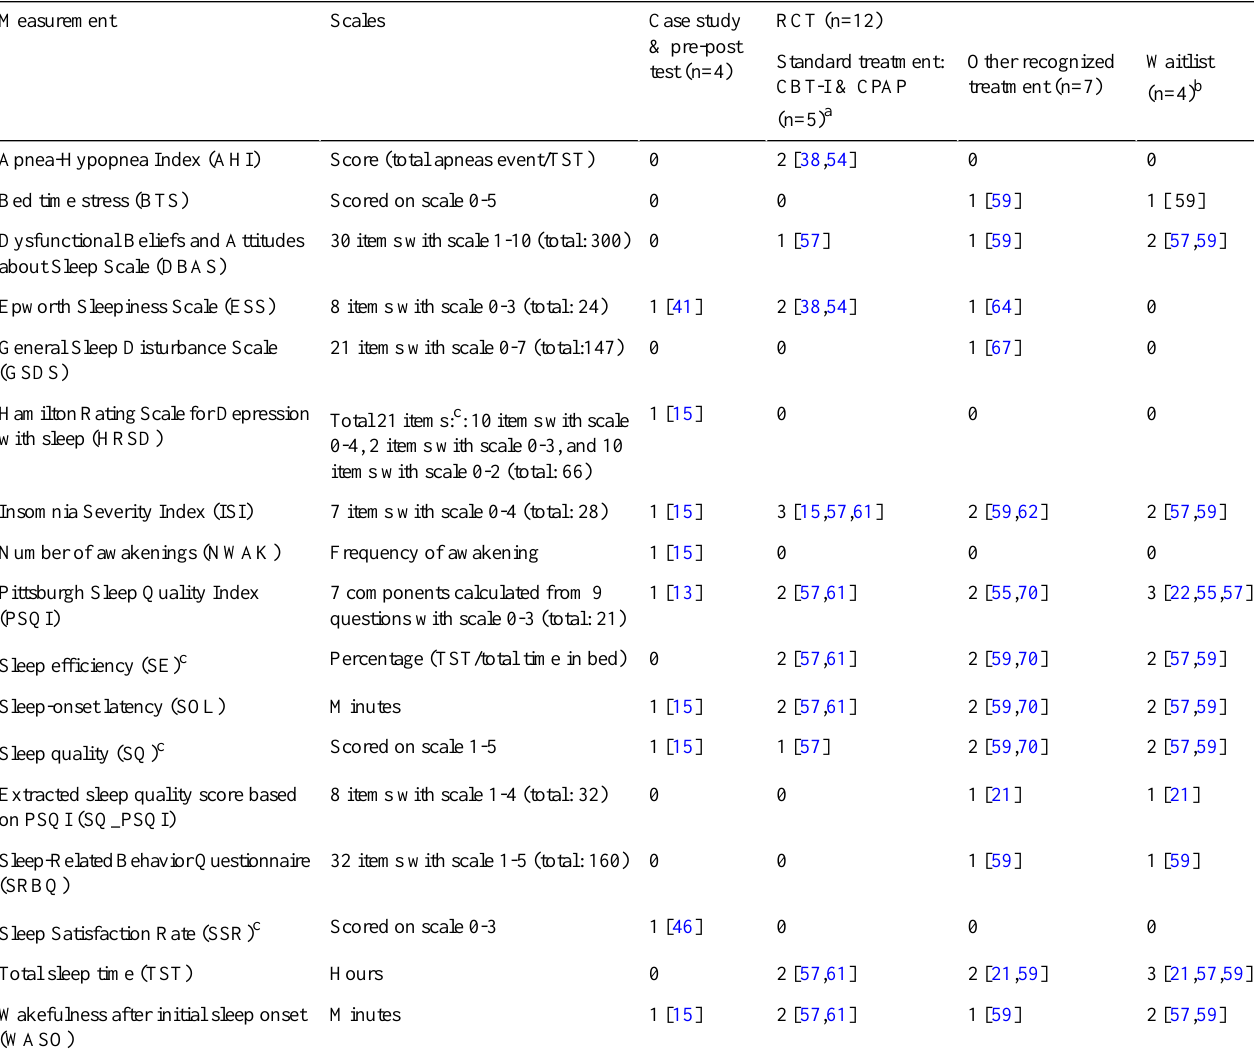
Table 2. Summary of sleep measurement tools and study design for mobile phone sleep intervention included in the systematic review